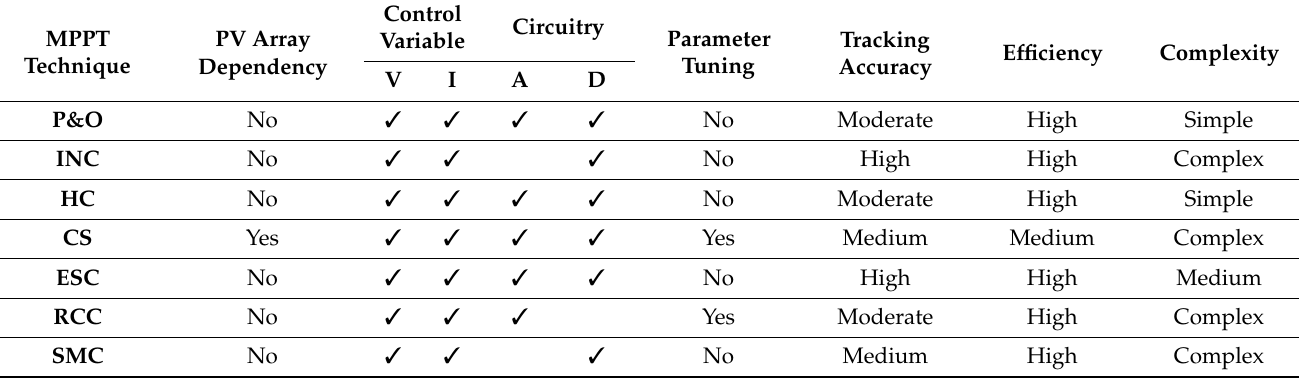
Table 4. A comparison of various online MPPT